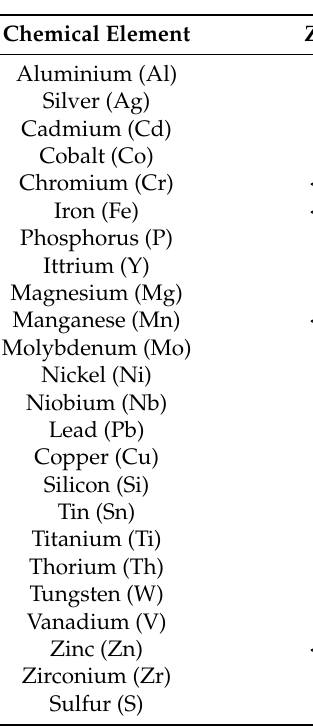
Table 6. XRF results of the aesthetic bracket. Percentage by weight.